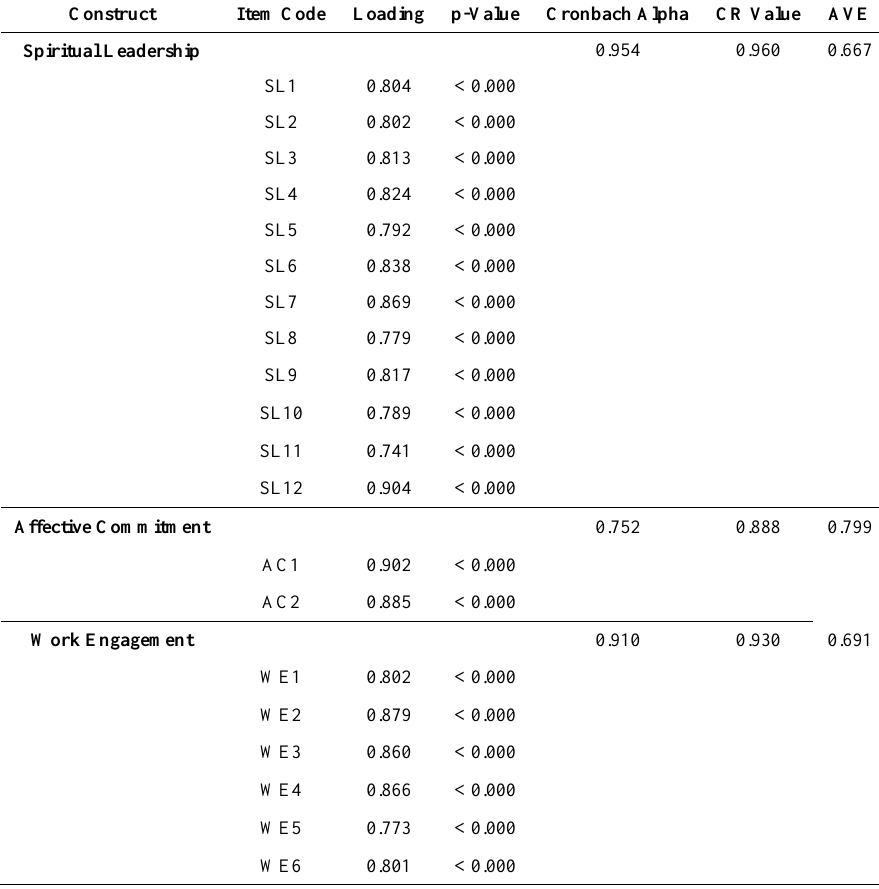
Table 2. Results of the measurement